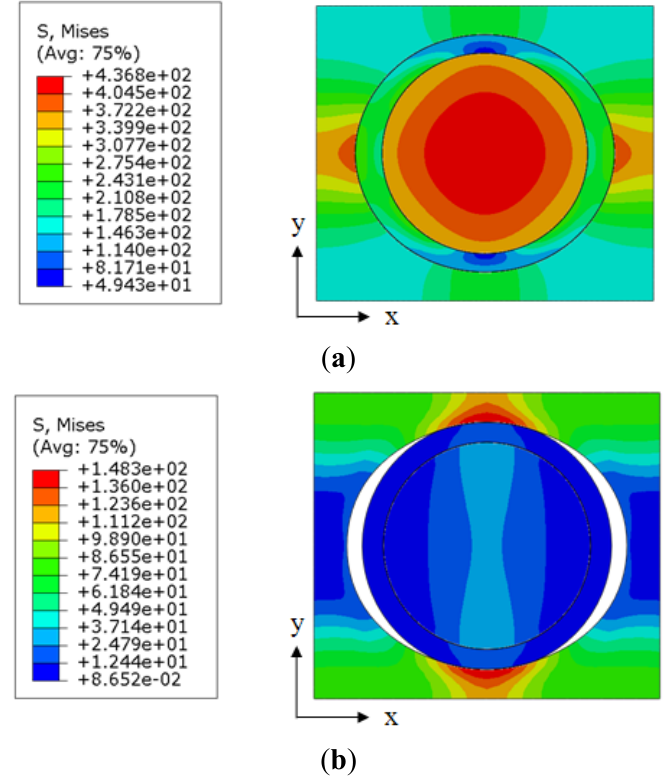
Figure 8. Stress distribution in the representative volume element models with different bonding conditions at the interphase–matrix interface: ( a ) perfect bonding; and ( b ) imperfect bonding (cut view in transverse plane).